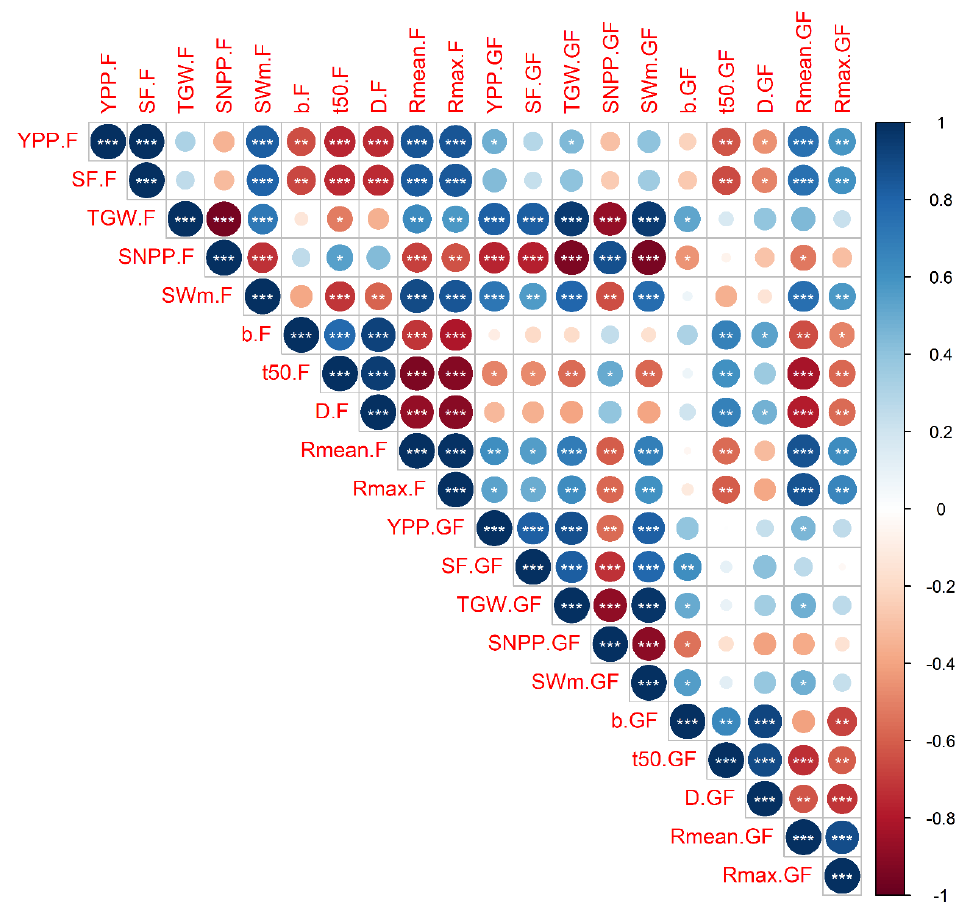
Figure 2. The Pearson correlation matrix between yield as well as yield and grain filling related parameters under low-temperature stress at flowering (F) and grain filling (GF) stages. (YPP) yield per plant; (SF) spikelet fertility; (TGW) thousand grain weight; (SNPP) spikelet number per panicle; (SW m ) spikelet weight at maturity; (b) the shape or steepness of the sigmoid curve; (t 50 ) days from flowering to 50% grain filling; (D) days from flowering to 95% (SW m ) (R mean ) grain filling rate; (R max) maximum grain filling rate. *, ** and *** represent the significant correlation at p < 0.05, p < 0.01 and p < 0.001, respectively.